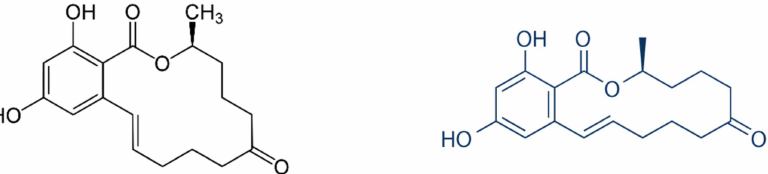
Figure 6. Chemical structures of the fungal extract zearalenone, an estrogenic metabolite produced by the fungal species Gibberella zeae (Sun et al., 2018)